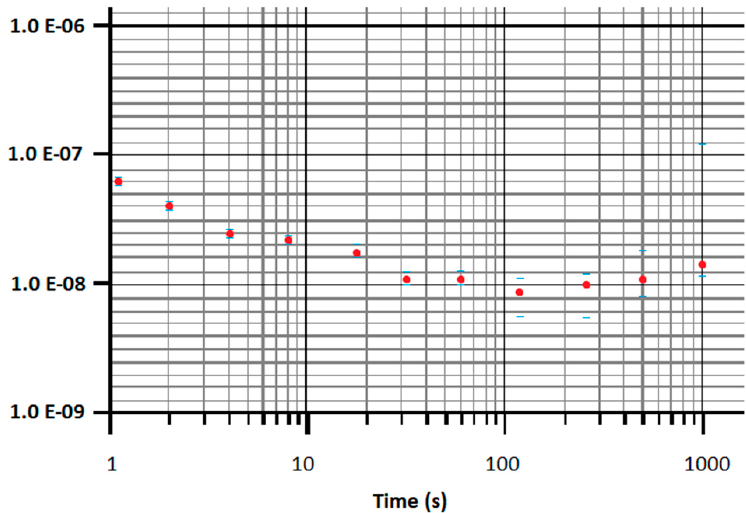
Figure 4. Results from stability test using Allan deviation as a stability analysis tool at 1–1000 s analysis windows.